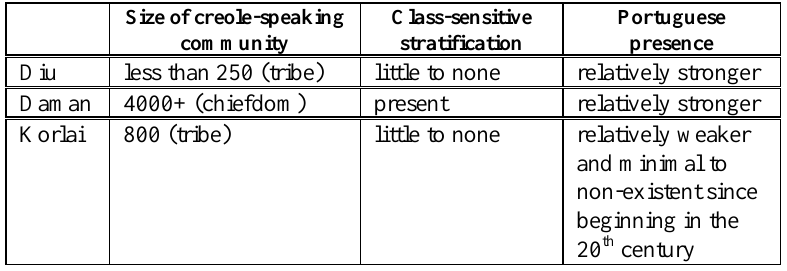
Table VI. Social type of and Portuguese presence in Diu, Daman, and